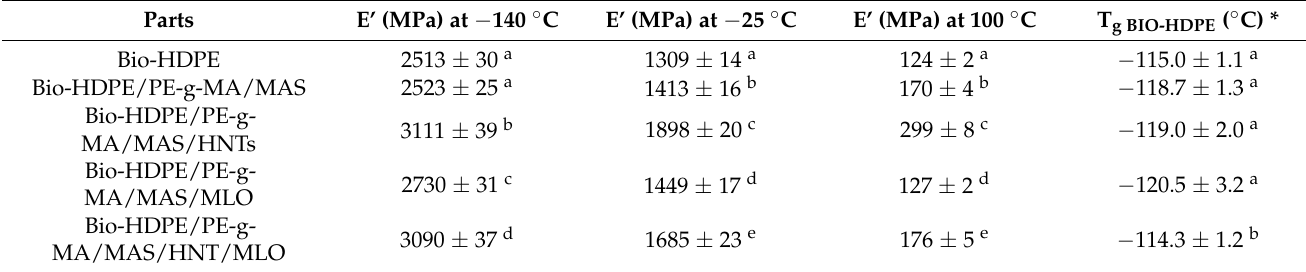
Figure 7. Plot evolution of ( a ) the storage modulus ( G (cid:48) ) and ( b ) the dynamic damping factor (tan δ ) of the injection-molded samples of Bio-HDPE/PE-g-MA/MAS blends with different compatibilizers. Table 5. Dynamic-mechanical properties of injection-molded samples of Bio-HDPE/PE-g-MA/MAS blends with different compatibilizers, at different